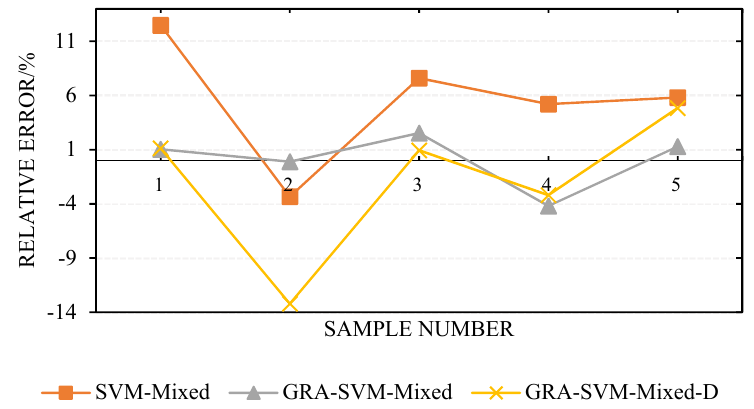
Figure 5. Relative prediction error for different input variables.